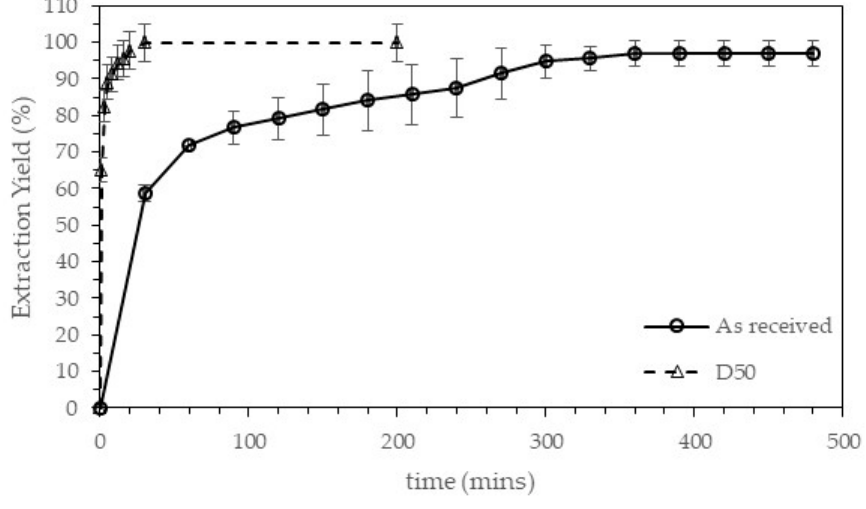
Figure 3. Sugar extraction from carob pod.